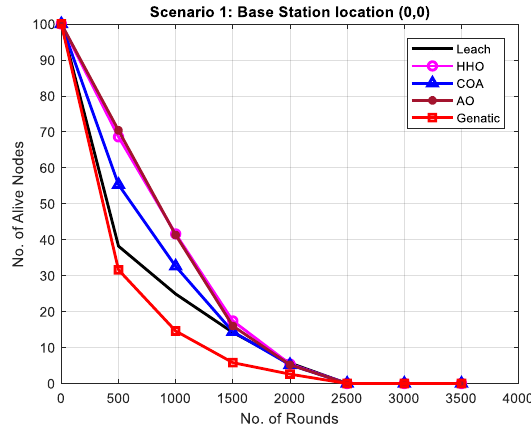
Figure 3. Number of alive nodes in case of scenario 1: BS at (0,0).